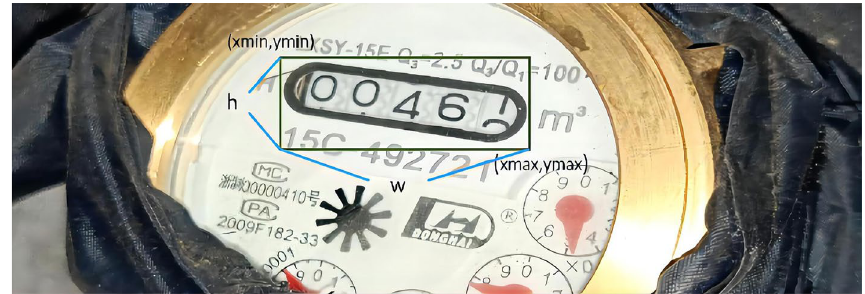
Figure 2. Picture label effect drawing.